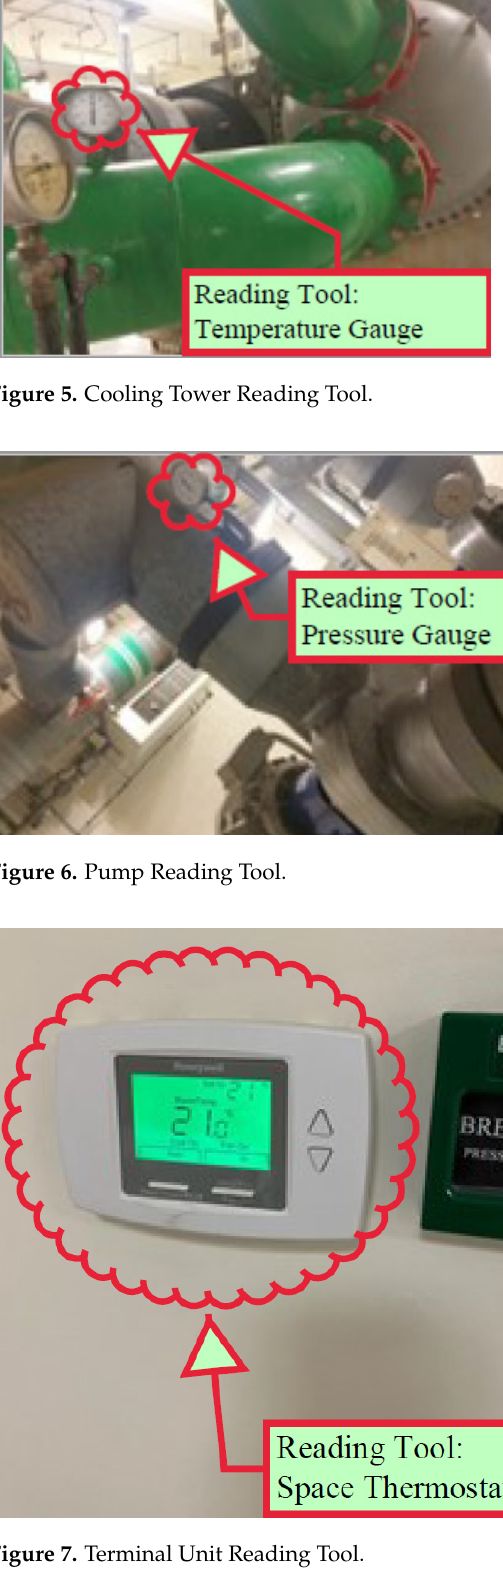
Figure 4. Chiller Reading Tool.